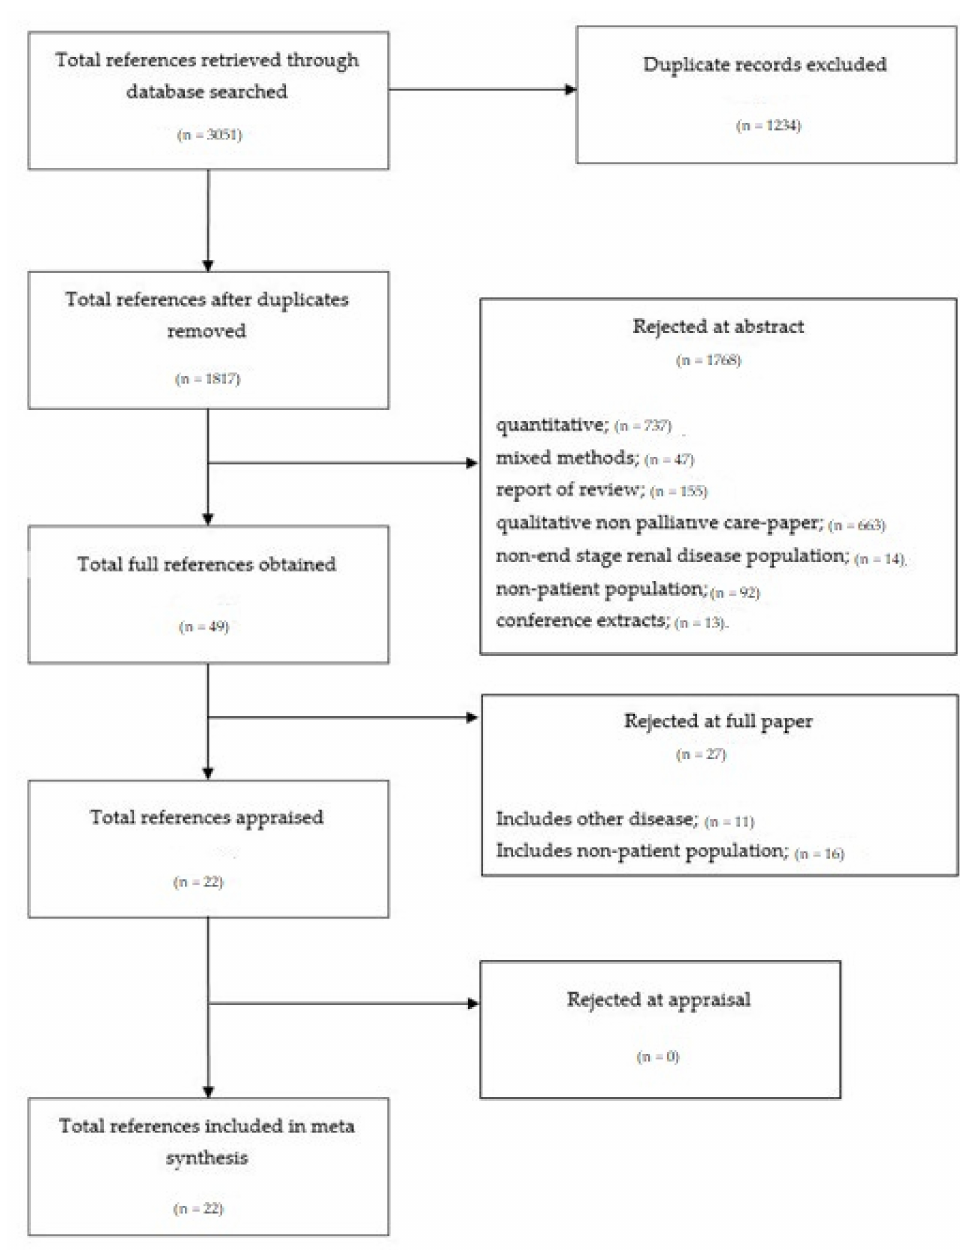
Figure 1. Flowchart of the meta synthesis